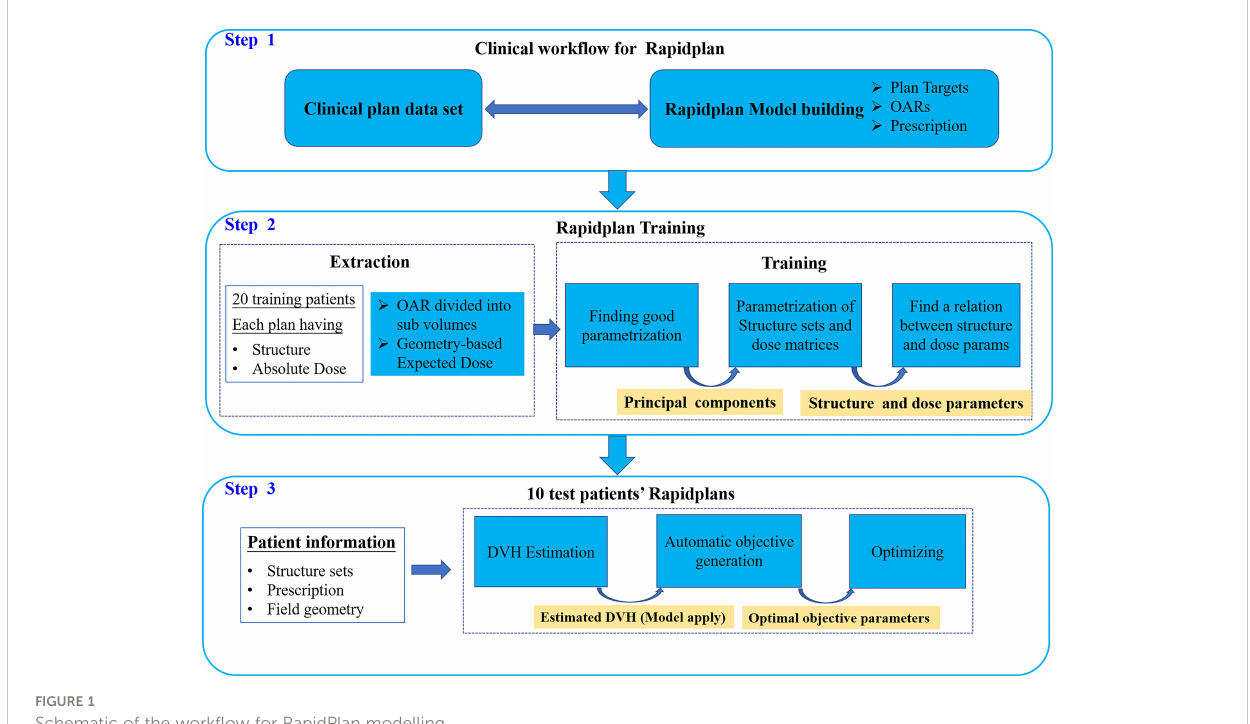
FIGURE 1 Schematic of the work fl ow for RapidPlan